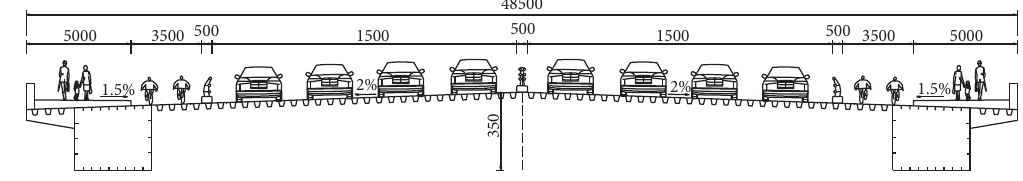
Figure 3: The cross-sectional view of the ultra-wide double-sided steel box girder (unit: mm).